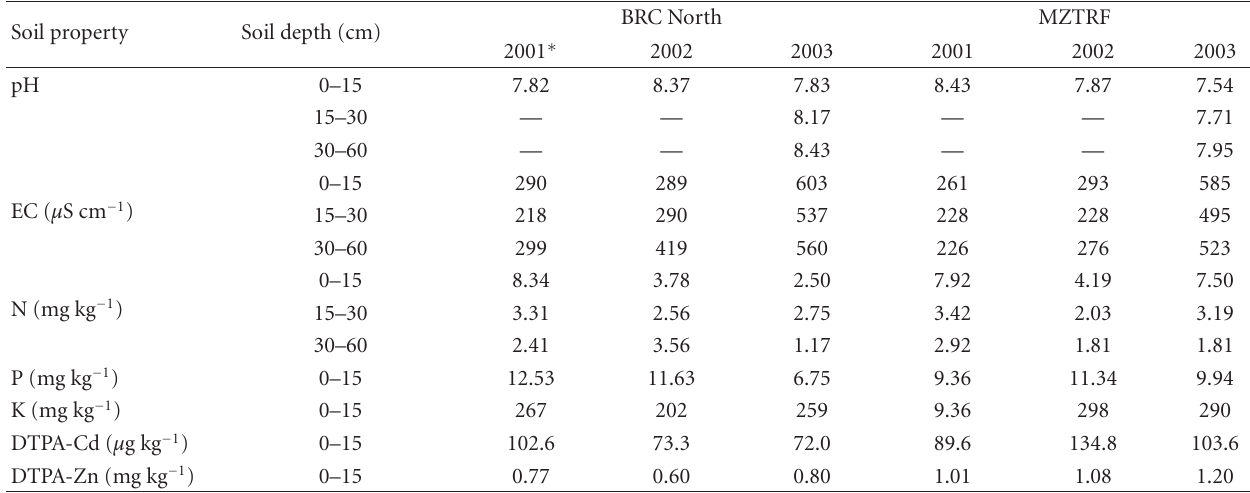
Table 1: Soil characteristics of the experimental sites prior to initiation of the study. Soil property